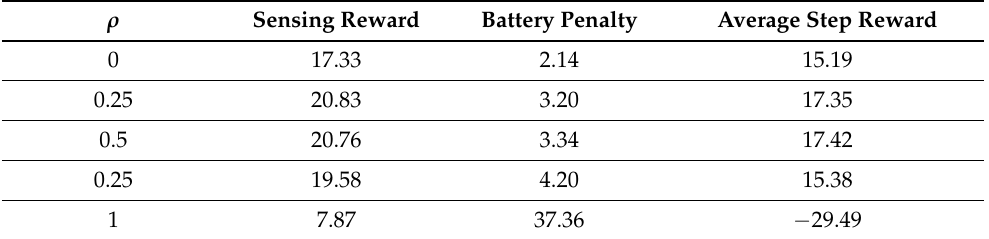
Table 2. Different parts of the performance of ConComm. The average step reward can be described as the difference between the sensing reward and the battery penalty.